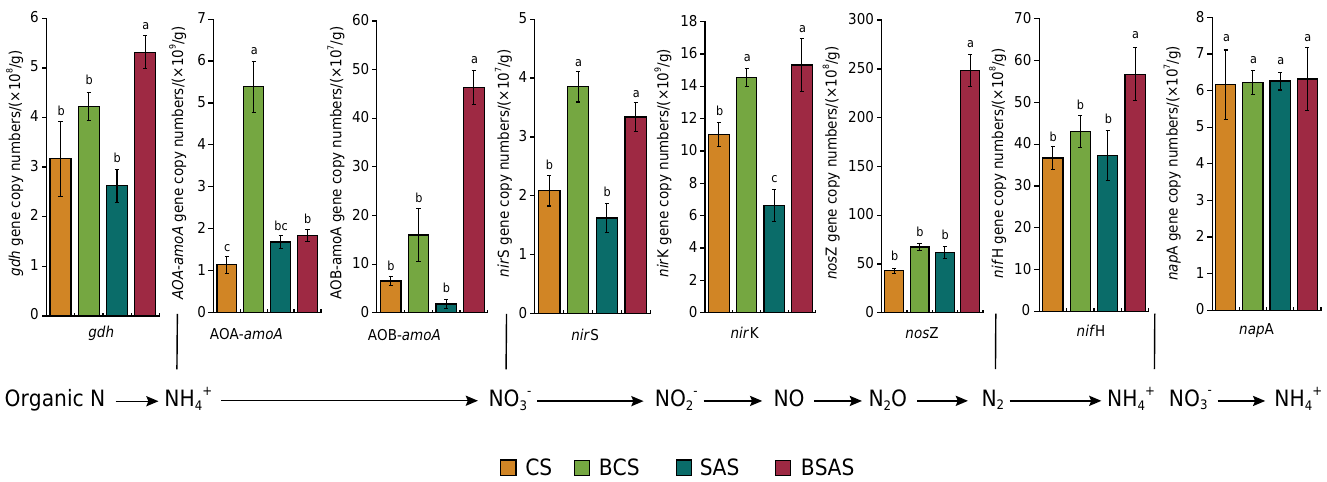
Figure 2. Effects of biochar application on the abundance of soil. Different letters above the bars indicate statistical differences among treatments at the significance level of